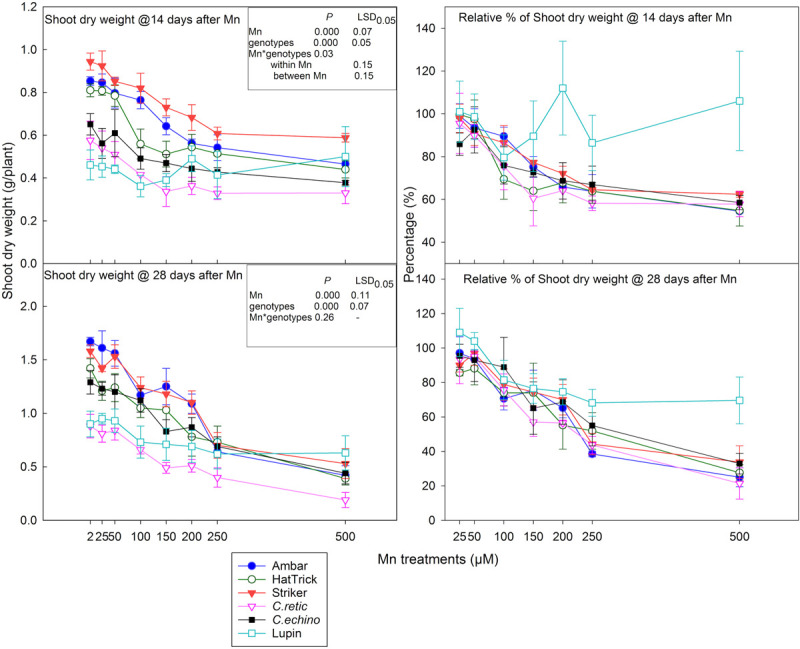
Shoot dry weight at 14 and 28 days after Mn treatments and their relative shoot dry weight percentage (in relation to 2 μM) of five Cicer genotypes and lupin. Vertical bars where visible represent the standard error of the mean.